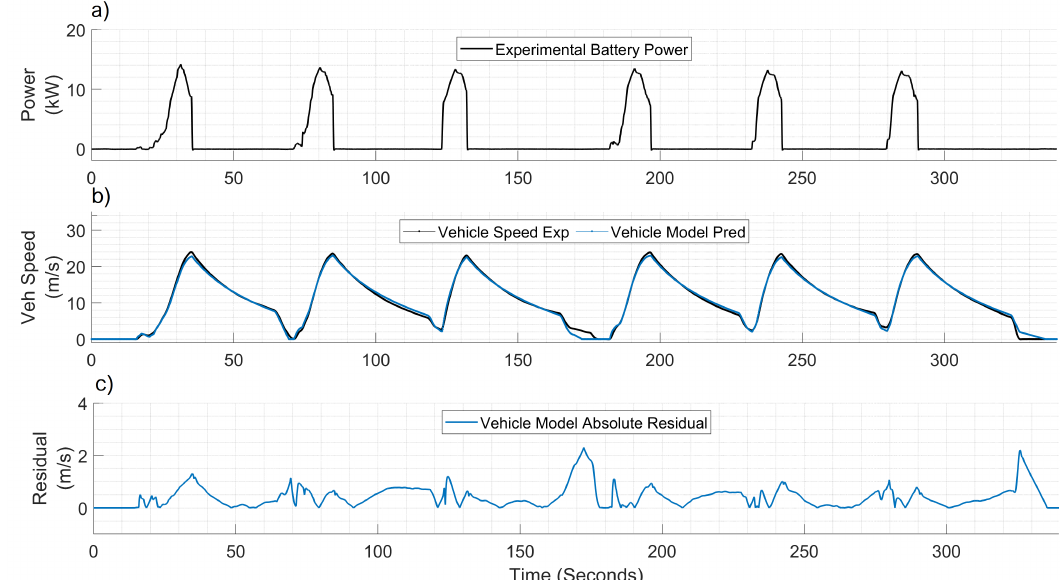
Figure 16. Test #4.1. Vehicle model performance: ( a ) battery power delivered, ( b ) predicted and measured velocity and ( c ) residual of the estimation.